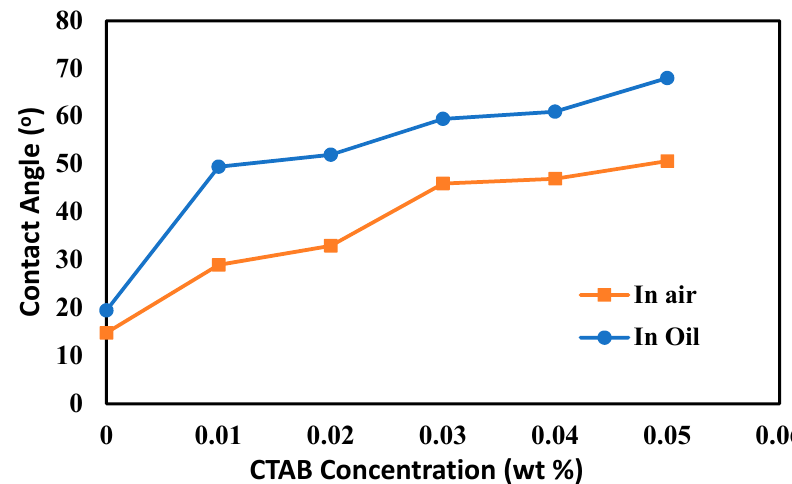
Figure 7. Variation of contact angles measured of a water drop in air (squares) and in oil (circles) as a function of CTAB concentration in a 1 wt% nanoclay dispersion.